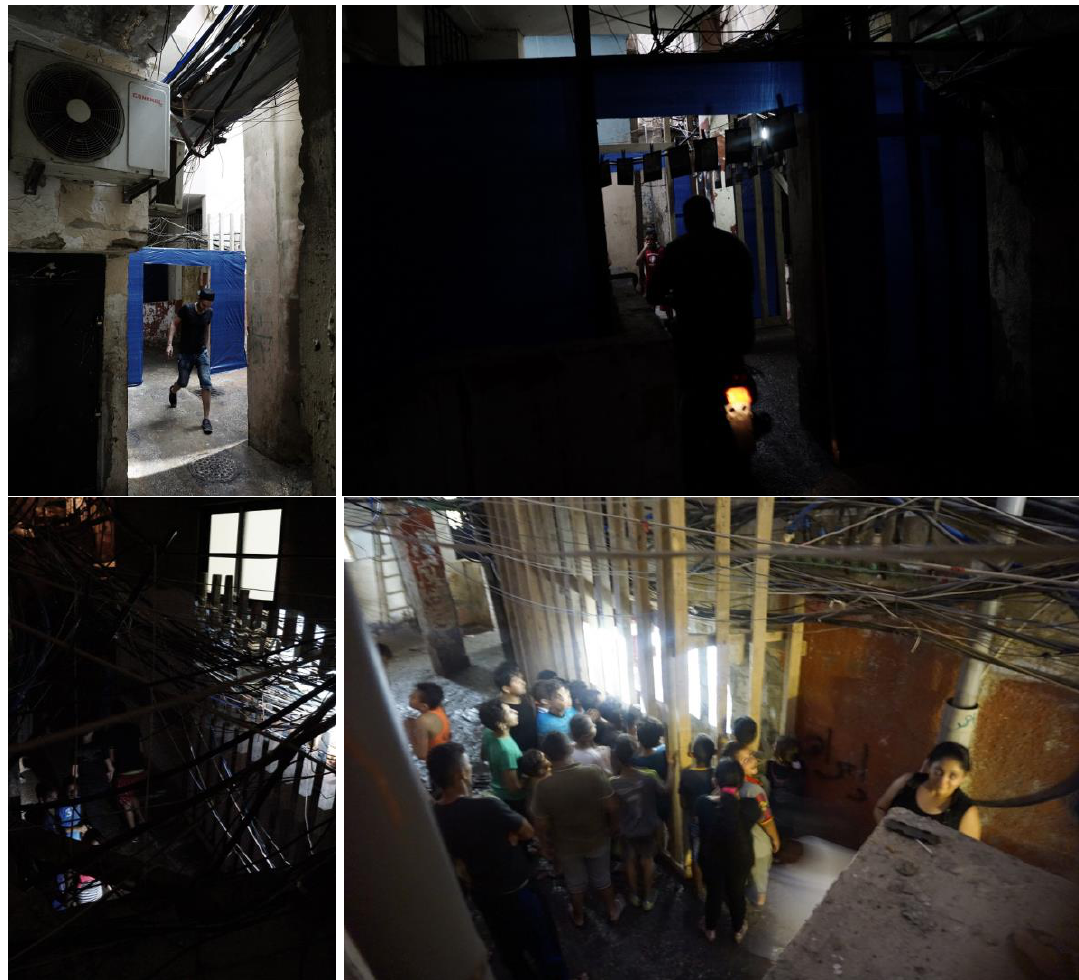
Image showing the camp inhabitants going about their daily lives while encountering the installations along the way and engaging with them in different ways. Some treat them as another natural element of the camp, while others address them as new operational devices within the camp’s tissue.